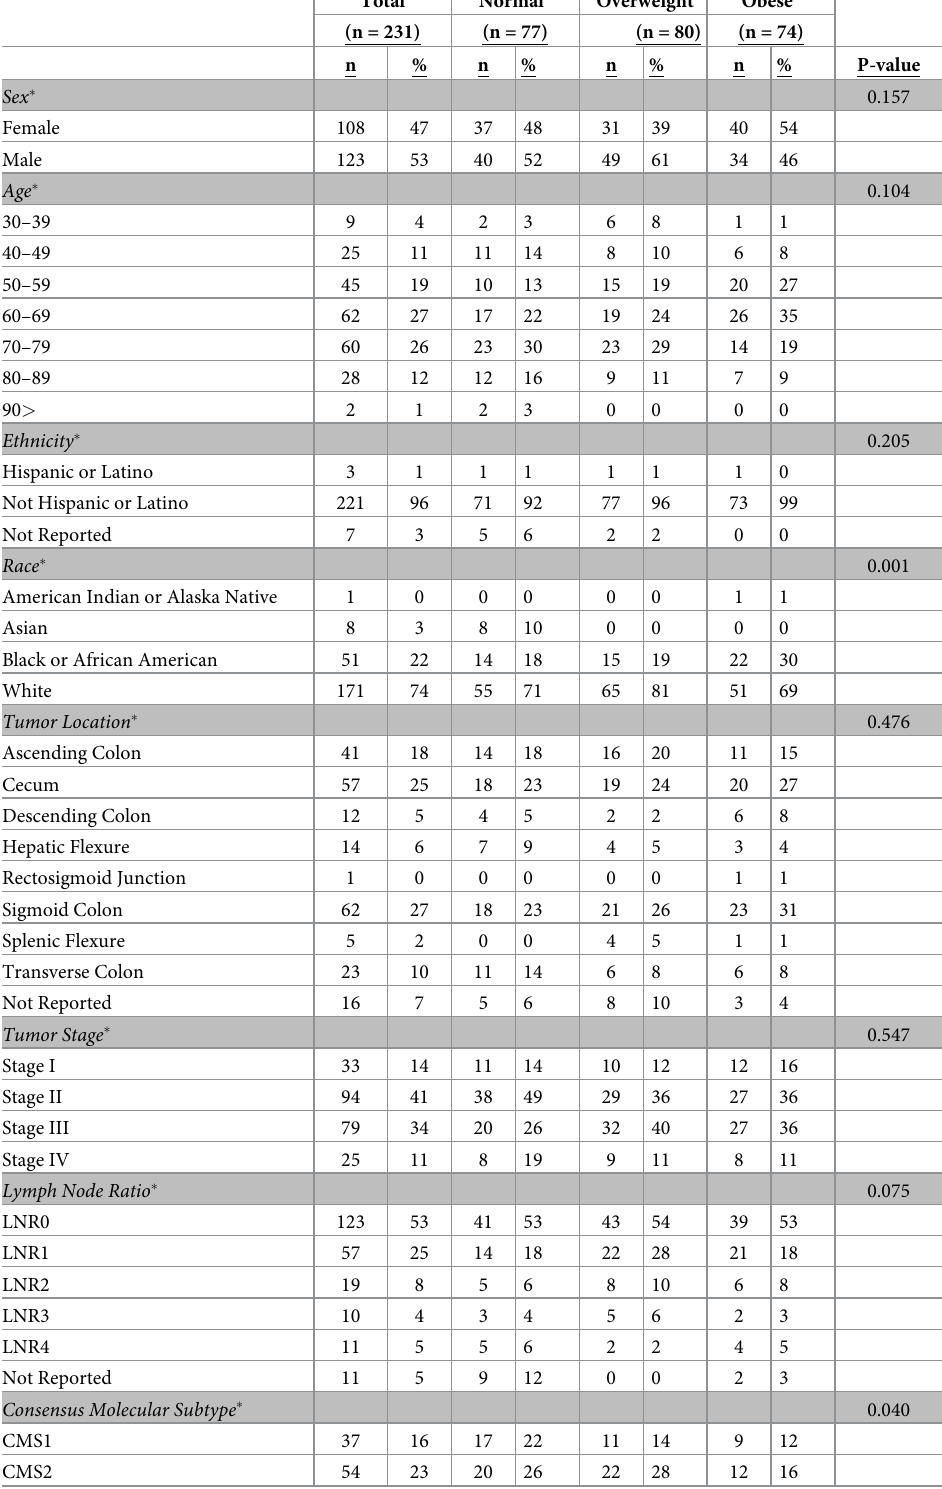
Table 1. Patient demographics and tumor